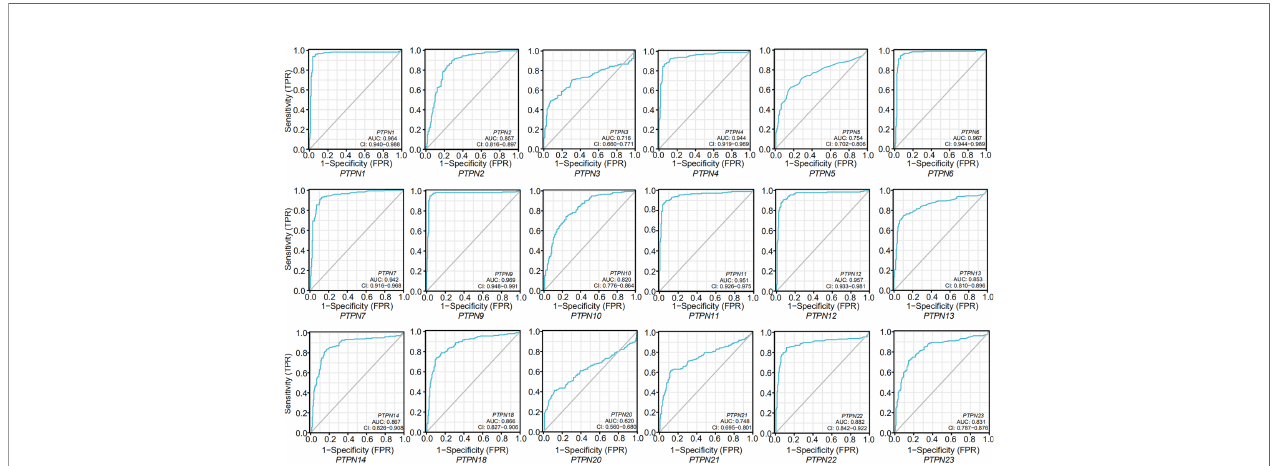
FIGURE 4 | ROC curves for the relationship of PTPNs expression and the malignant progression of pancreatic